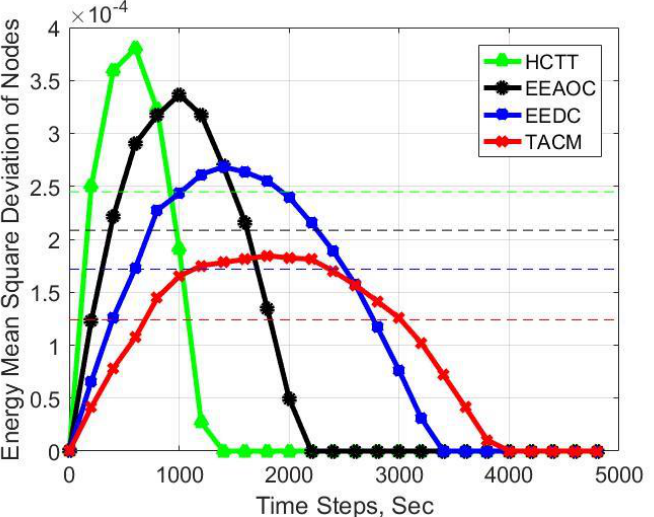
Figure 12. Experimental result for number of energy mean square deviation of nodes.